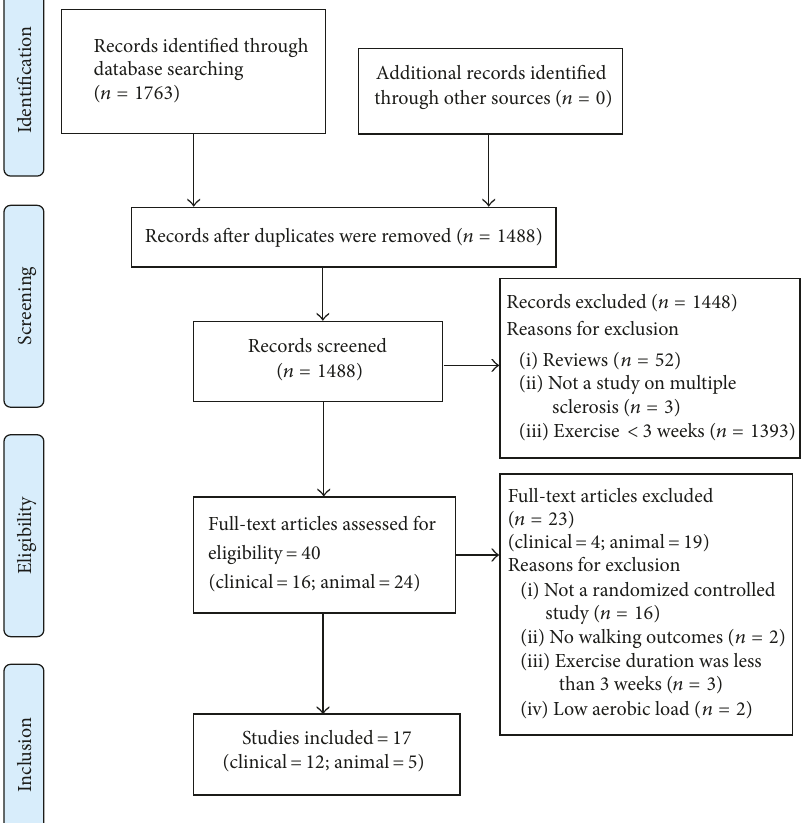
Figure 1: Flow chart - Systematic search